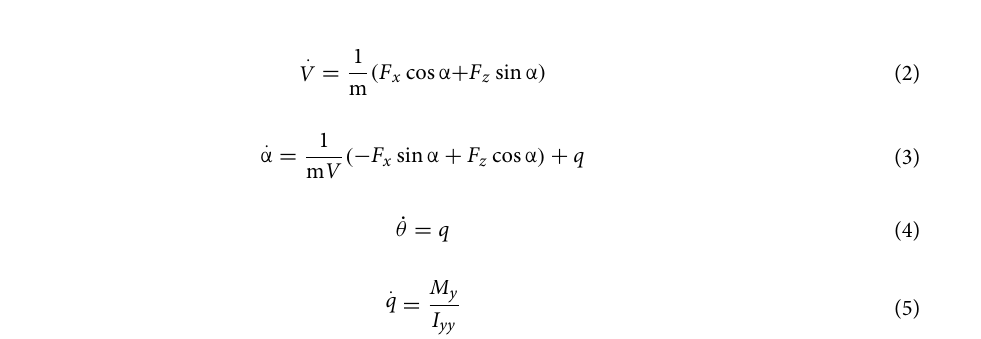
Figure 12. Diagram of American coordinate system and scale model